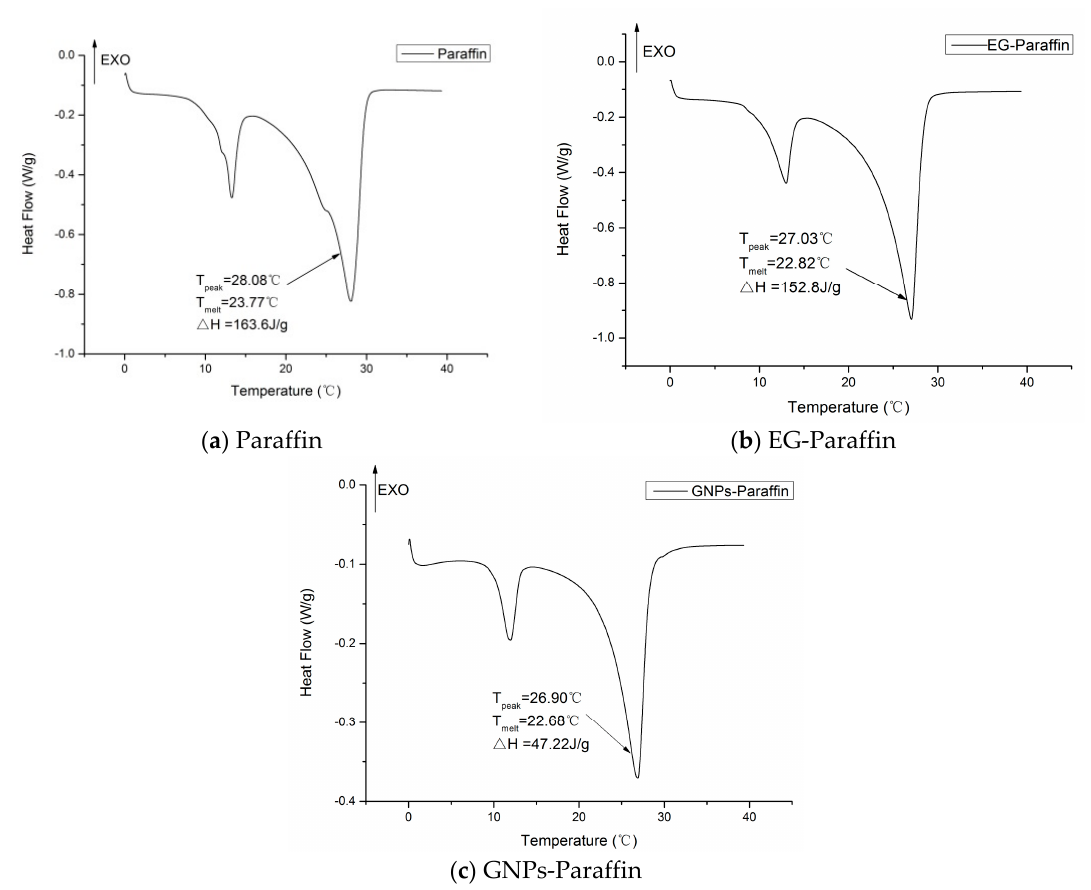
Figure 3. DSC curves - Paraffin and CPCMs. ( a ) Paraffin ( b ) EG-Paraffin and ( c ) GNPs-Paraffin.